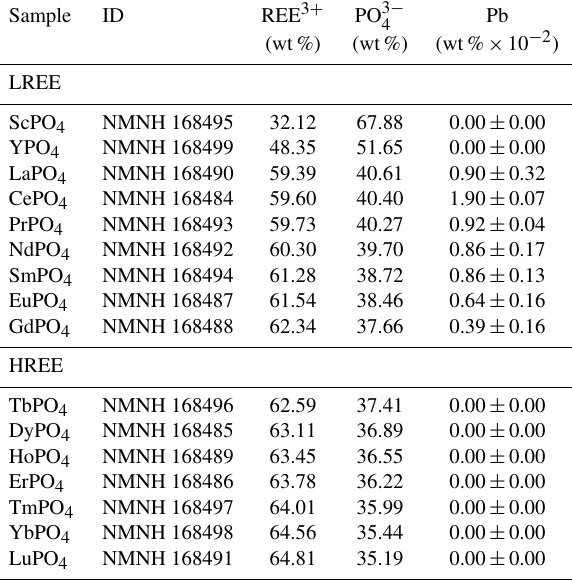
Table 1. Overview of rare earth element (REE) phosphate sam- ples from the Smithsonian National Museum of Natural History used in this study for the LiF spectral library (based on Jarosewich and Boatner, 1991; Donovan et al., 2002, 2003; LREE: light REE; HREE: heavy REE; ID: identification number of the Smithsonian National Museum of Natural History; data sheets at Smithsonian National Museum of Natural History (2019)) Pb trace analysis values represent the average mass fraction of 10 measurements from instrumental neutron activation analysis. Values are given in wt% × 10 − 2 to reduce number of zero digits. The given uncertainty values state 1 standard